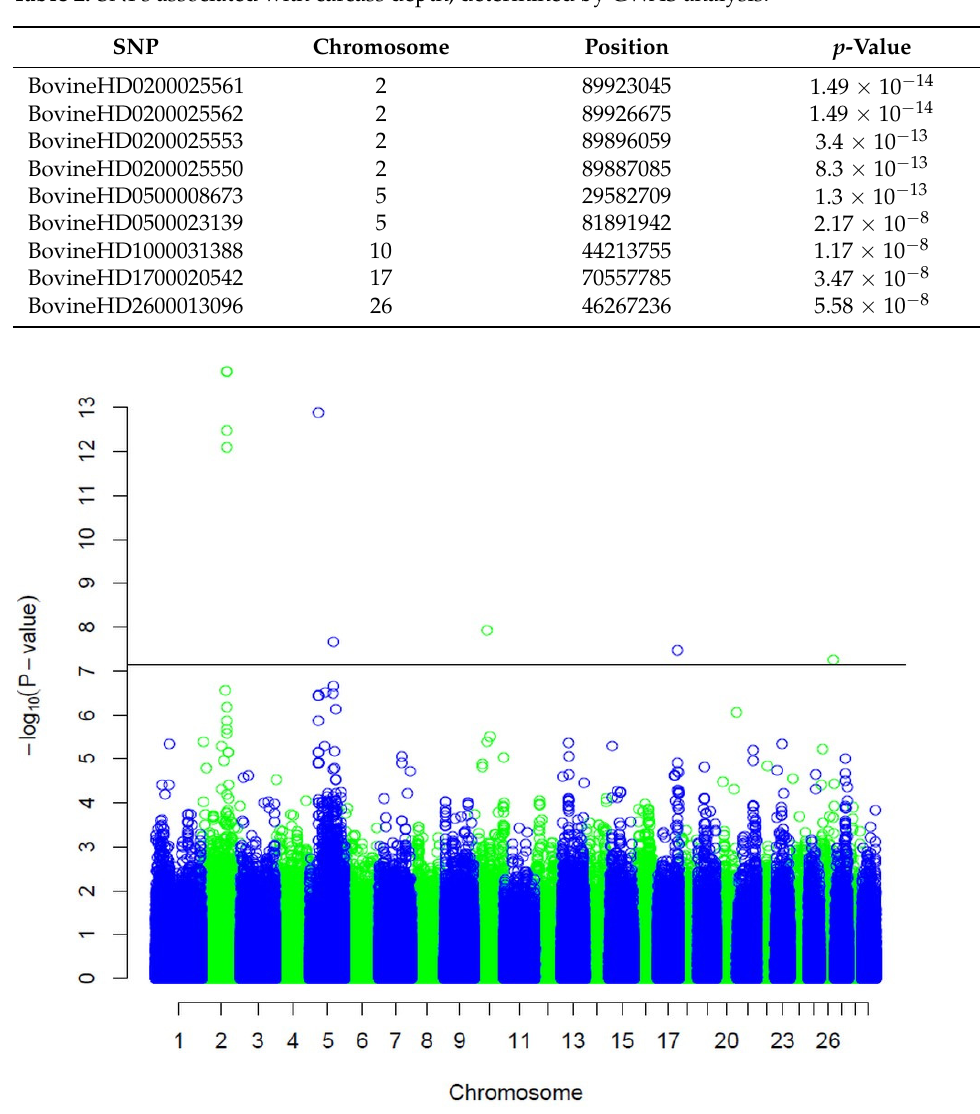
Figure 2. Manhattan plot of − log10 (p) for carcass depth. The horizontal line represents the thresh- old.